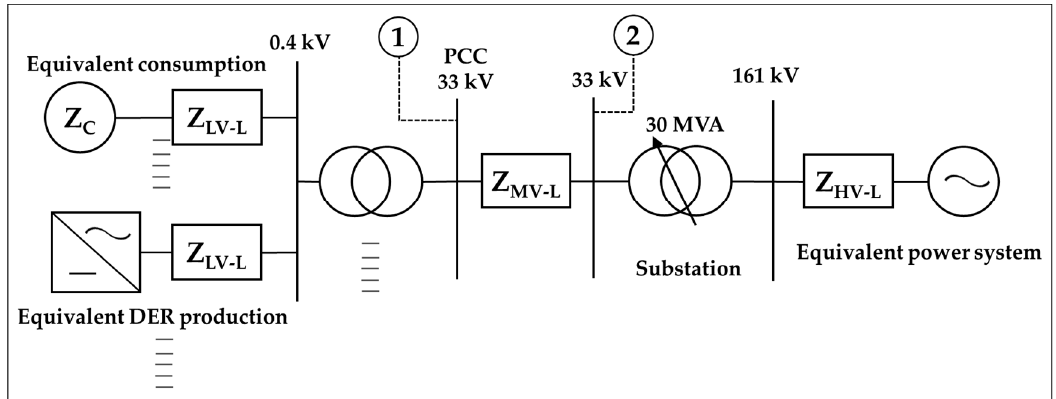
Figure 1. Single line diagram of the grid connected with renewable energy sources, e.g., solar plants. ( Z C : Consumer impedance, Z LV − L : Impedance of low voltage line, Z MV − L : Impedance of medium voltage line, Z HV − L : Impedance of high voltage line, PCC: point of common coupling, DER: distributed energy sources). Points 1 and 2 are designated for measurements at PCC and substation respectively.